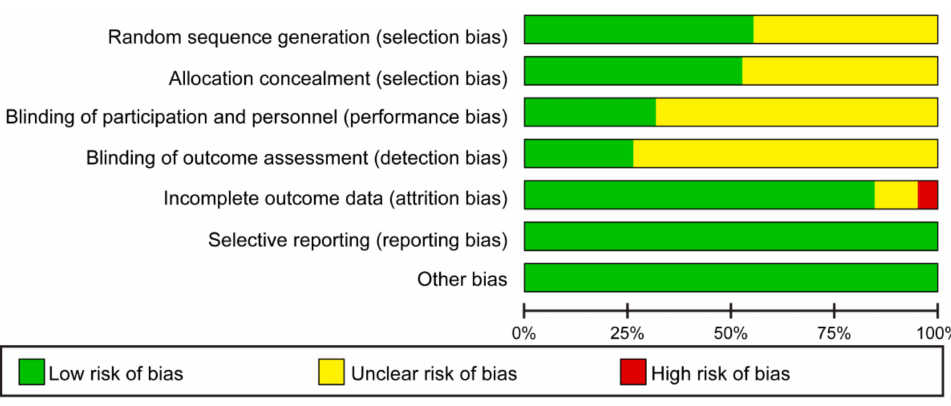
Figure 2. Risk of bias